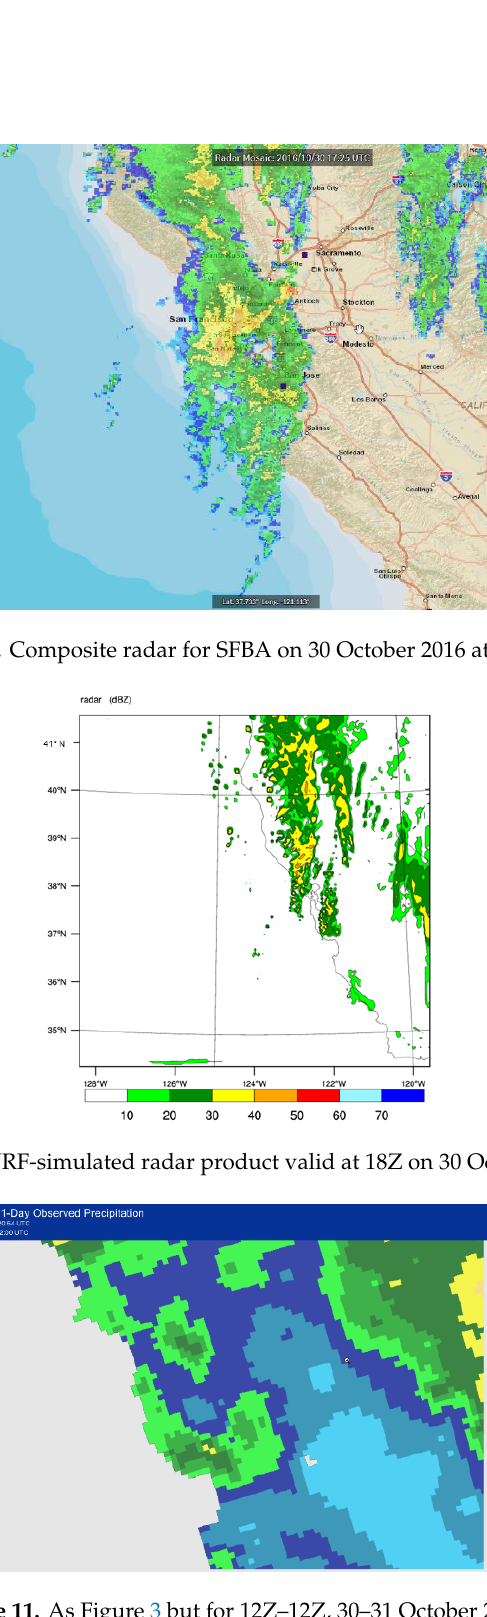
Figure 11. As Figure 3 but for 12Z–12Z, 30–31 October 2016.